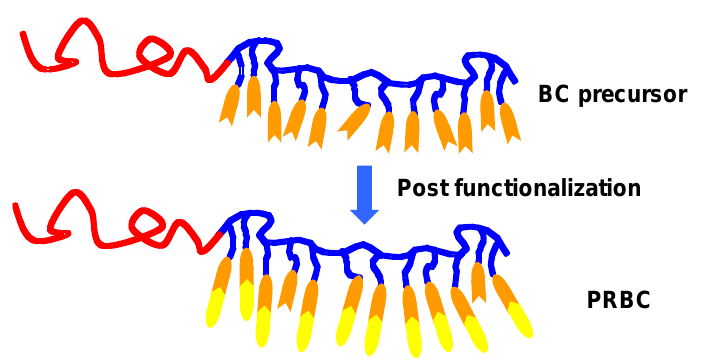
Figure 4. Schematic illustration of PRBCs prepared by post-functionalization.